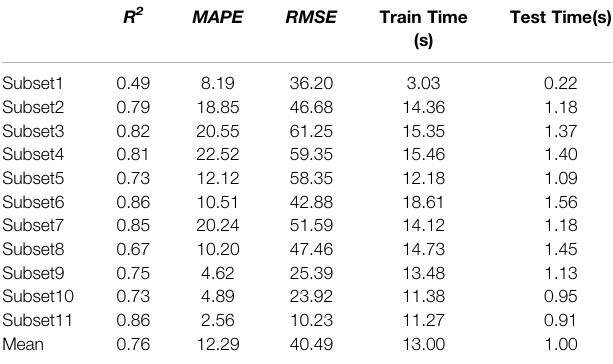
TABLE 7 | Performance indicators in different subsets.